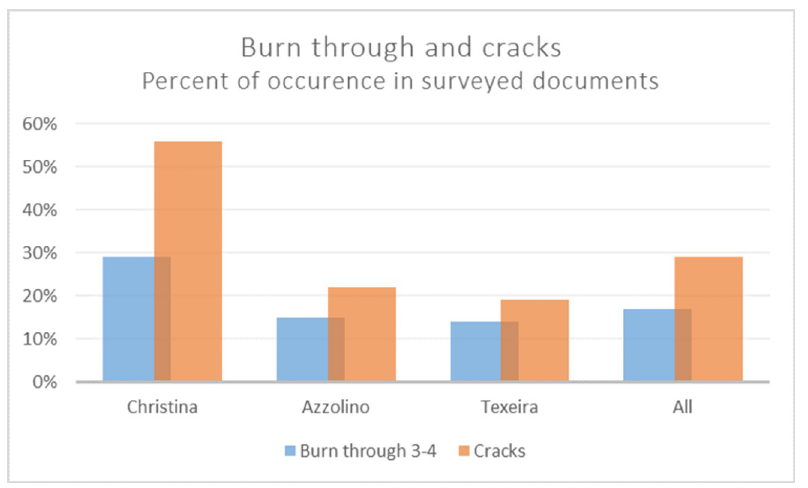
Fig 11. Burn through and cracks in condition survey. Percent of surveyed documents displaying burn through 3–4 and cracks in ink layer, according to writer. Of the 314 documents that were assessed in the survey 55 were written by Christina, 46 by Azzolino, 43 by Teixeira and the rest of the documents by circa 35 other authors.